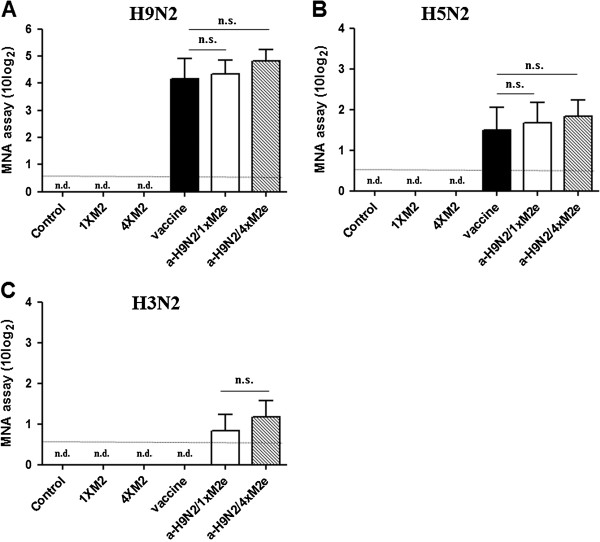
M2e protein induces neutralization of influenza virus in mice. 1×M2e, 4×M2e, a-H9N2, a-H9N2/1×M2e, or a-H9N2/1×M2e was used to immunize mice. Three weeks after boost vaccination, sera were collected. The samples were serially diluted two-fold. Serum neutralization activity was tested against 102 TCID50/ml of respective viruses. (A) A/chicken/Korea/ma163/04 (ma163/H9N2), (B) A/aquatic bird/Korea/maW81/05 (maW81/ H5N2), or (C) A/Philippines/2/82 (Phil82/H3N2) virus for 30 min, followed by incubation with MDCK cells for 48 h. Data are representative of three independent experiments with three replicate wells per group. The lower limit of detection (0.5 10 log2TCID50) is indicated by a dotted line.